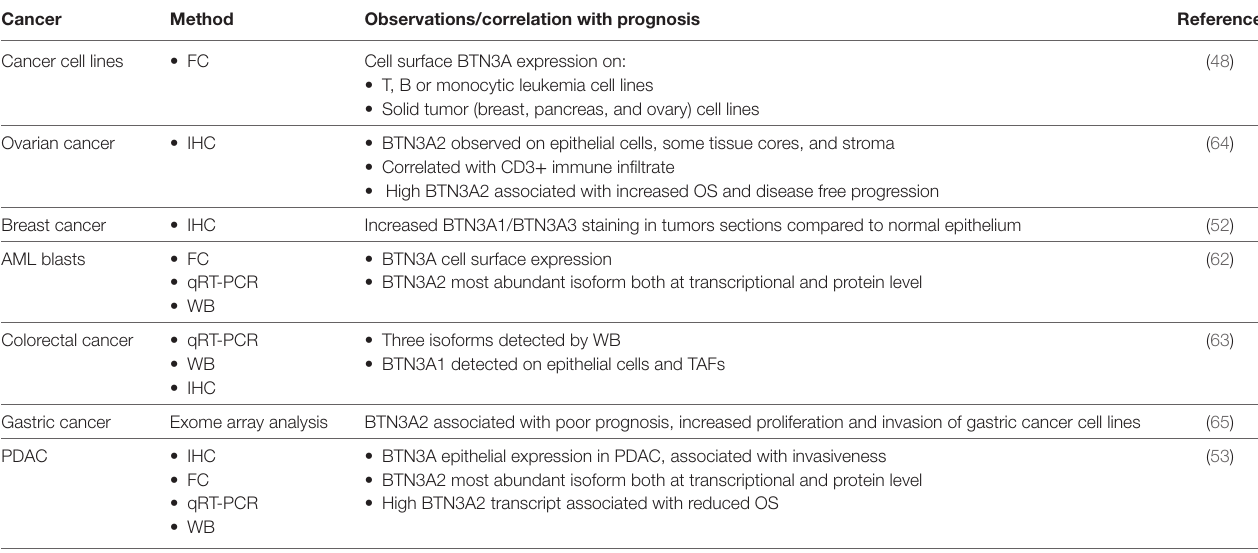
TABLe 2 | BTN3A expression in tumors.